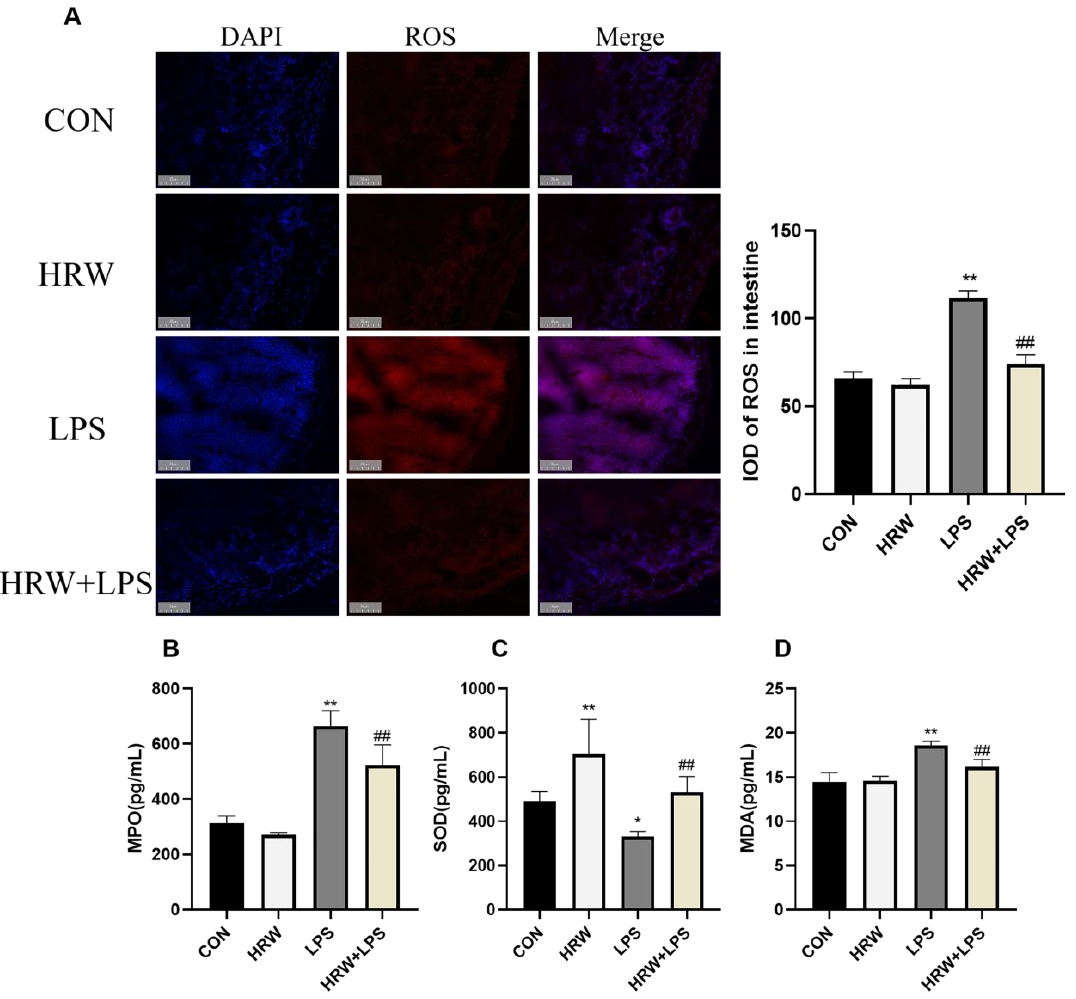
Figure 5. Effects of HRW on oxidative stress-related indicators in rats with chronic inflammation. ( A ) Immunofluorescence analysis and quantification of ROS in ileal tissue (200 × ). ( B ) Levels of MPO in ileal tissue. ( C ) Levels of SOD in ileal tissue. ( D ) Levels of MDA in ileal tissue. * p < 0.05; **, ## p < 0.01.